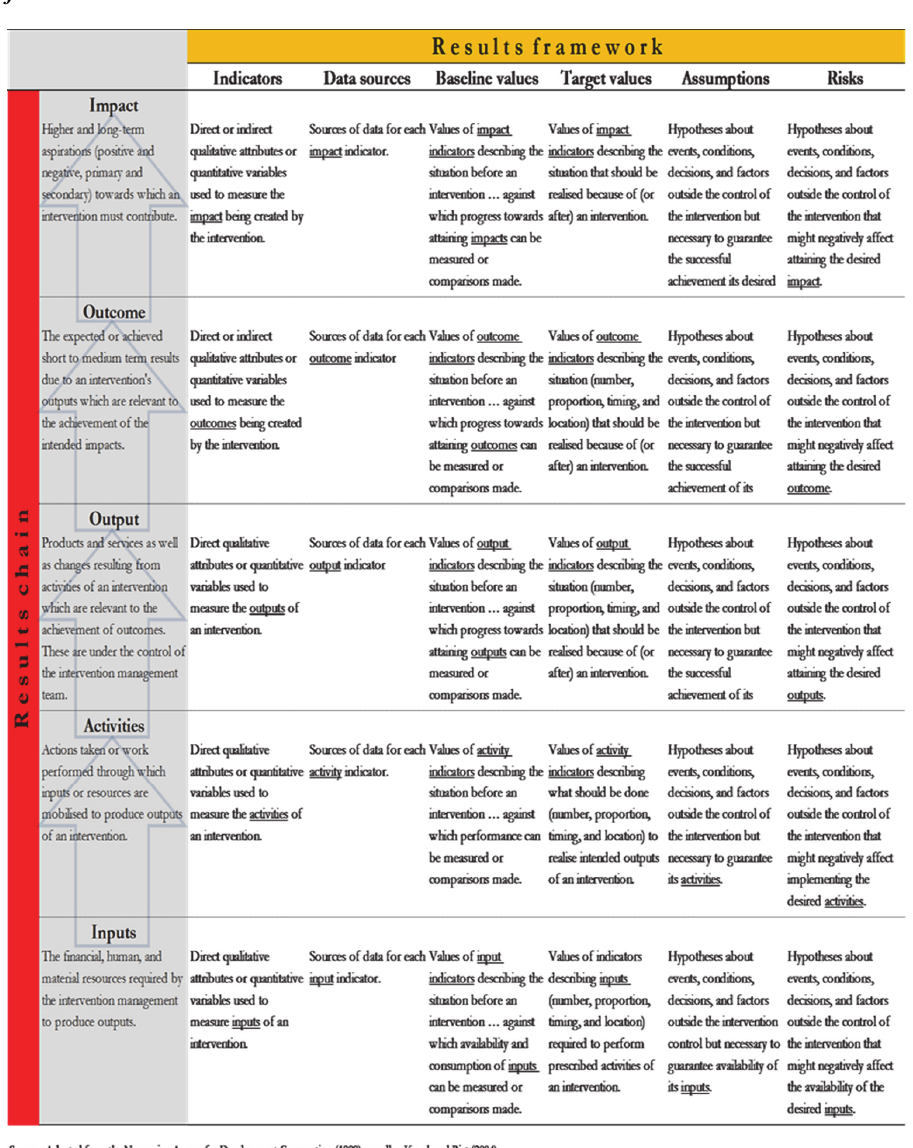
Table 1: Illustrating the important elements of the results chain and the results